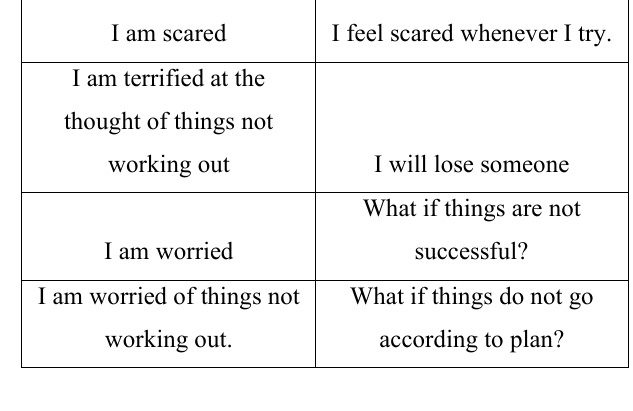
Table 7. Intent #Life_issue Details and case examples configured